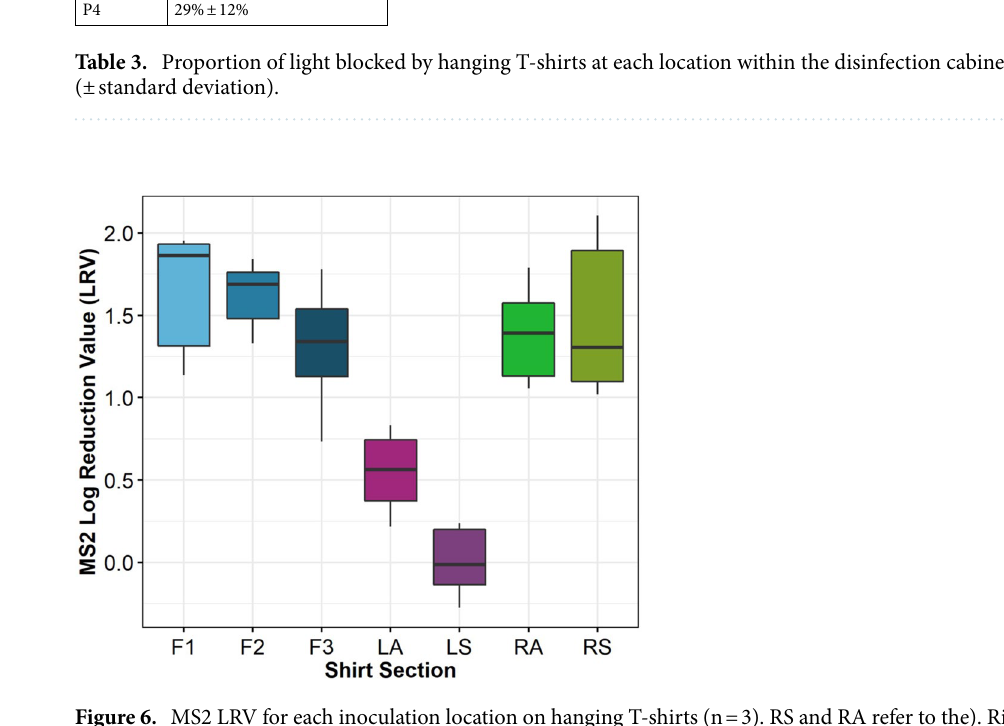
Figure 6. MS2 LRV for each inoculation location on hanging T-shirts (n = 3). RS and RA refer to the). Right Side (RS) and Right Arm (RA); Left Sleeve (LS) and Left Armpit (LA); Front 1,2,3 (F1, F2, and